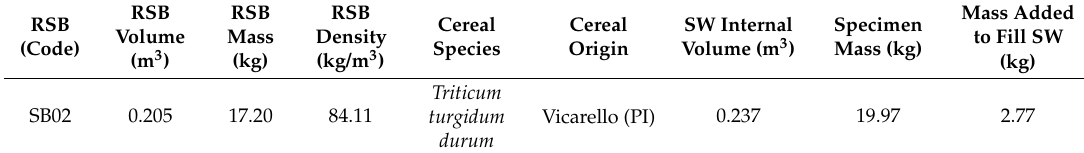
Table 8. Dimensions and density of the straw-bale and of the specimen SB02.